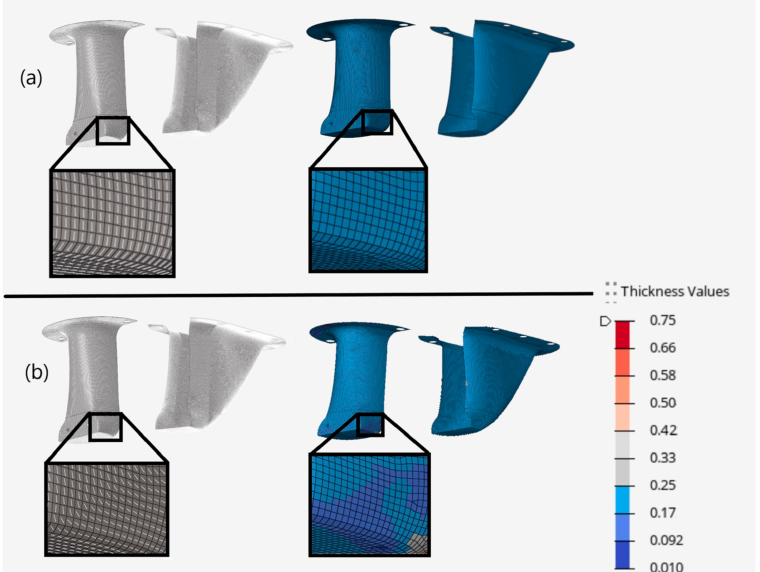
Figure 7. Example of unidirectional fiber angles left and ply thickness right without draping ( a ) and with draping ( b ) for partitioned